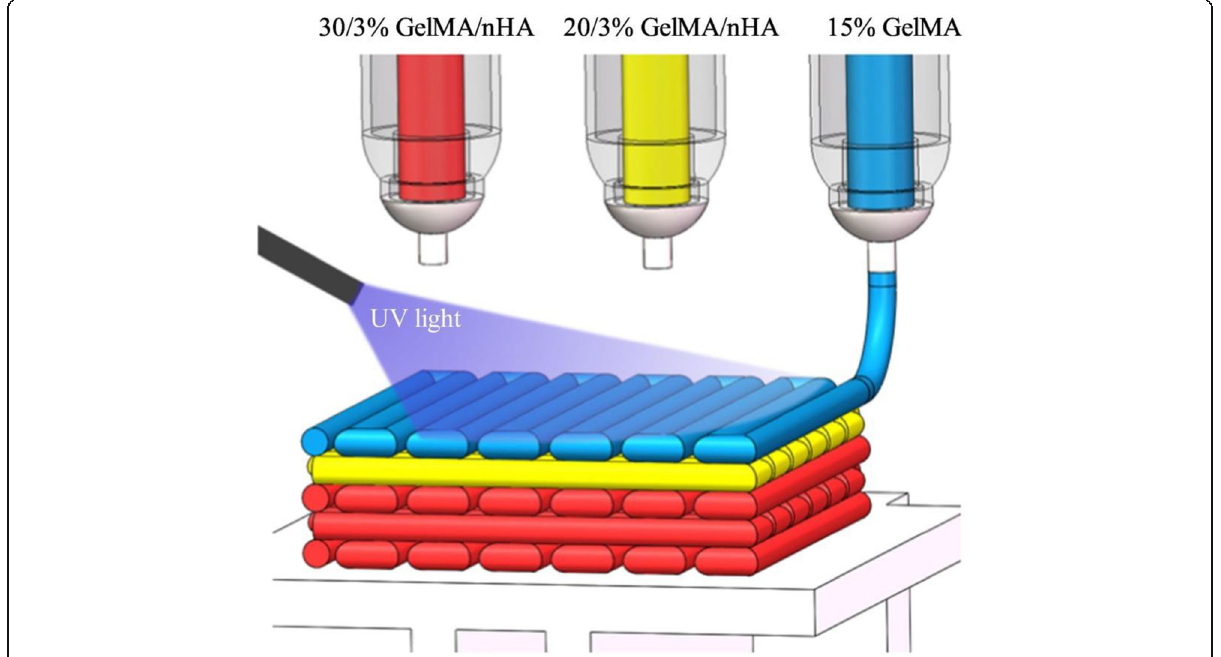
Fig. 2 Schematic diagram of preparation of multi-layered GelMA/nHA scaffold. Reproduced with permission [71]. Copyright (2019), Elsevier Ltd.